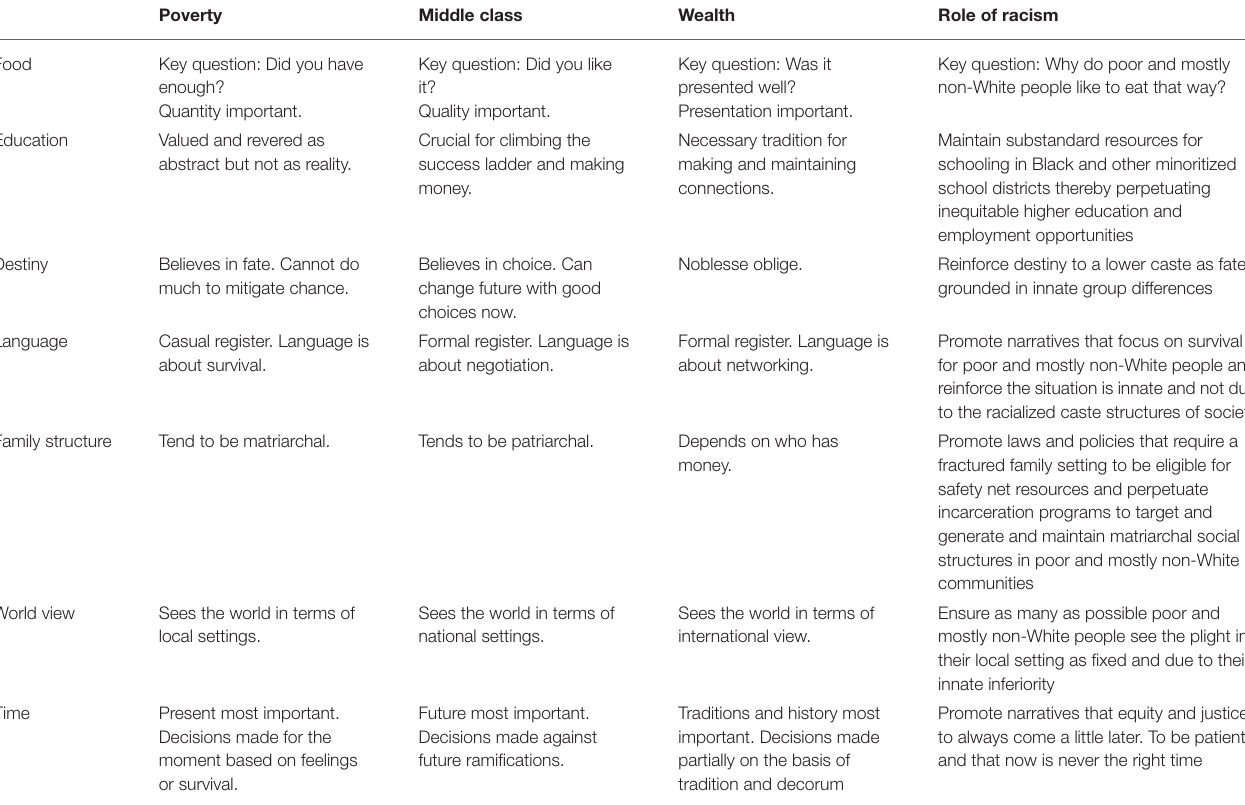
TABLE 1 | Socioeconomic class and values of key determinants of health [adapted from Payne and Blair (75)].